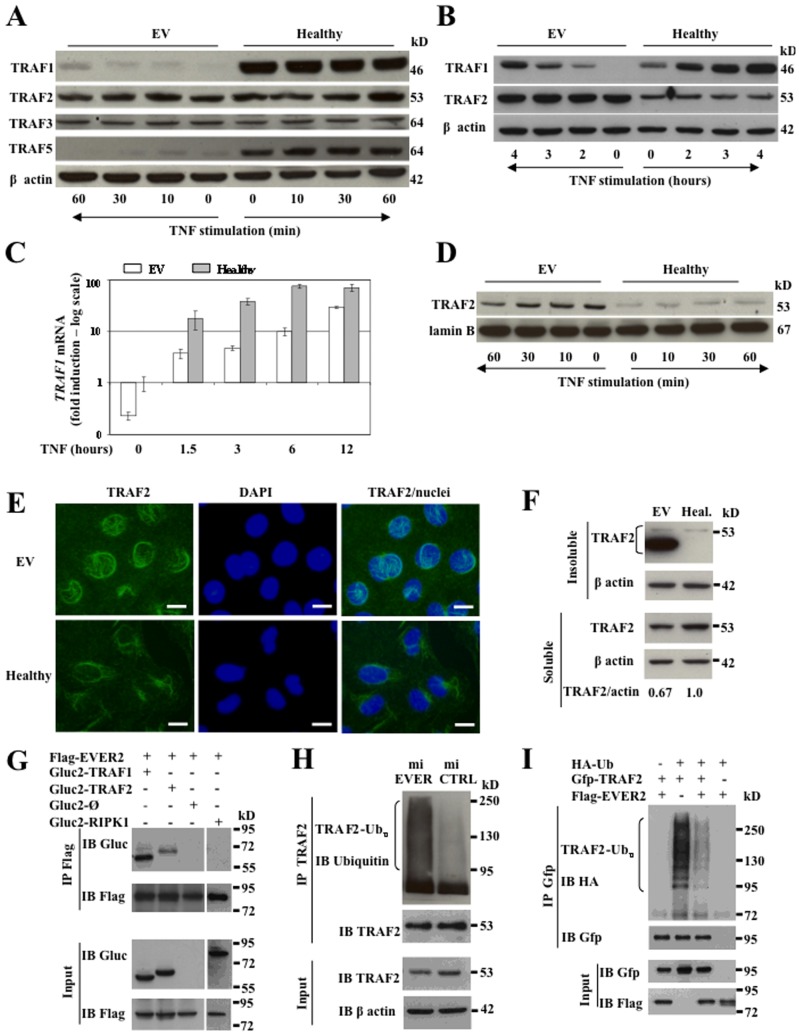
EVER2 deficiency impairs TRAF protein production.(A–D) EV and Healthy cell lines were left untreated or stimulated with TNF for the time periods indicated. (A) Cytoplasmic extracts were subjected to western blotting. The results shown are representative of three independent experiments. (B) Whole-cell lysates were analyzed by western blotting after various times. (C) qRT-PCR was used to measure the induction of TRAF1 1.5–12 h after stimulation with TNF. Results are reported as fold-induction with respect to untreated cells. The basal level for the Healthy cell line was set to 1. A logarithmic (log) scale was used for the Y axis. Experiments were performed twice independently. (D) Nuclear extracts were subjected to immunoblot analysis with TRAF2 antibody for the times indicated. The results shown are representative of three independent experiments. (E–F) EV and Healthy (Heal.) cell lines were left untreated. (E) Cells were stained for TRAF2; the nucleus was stained with DAPI. Bars, 20 µm. (F) Keratinocytes were lysed in Triton X-100 lysis buffer. Soluble and insoluble fractions were subjected to immunoblot analysis with TRAF2 antibody. The TRAF2 and actin bands were quantified by densitometry for the soluble fraction. Results are reported as the ratio of TRAF2 to actin. The ratio obtained for the Healthy cell line was set to 1. (G) HEK-293T cells were transfected with plasmids encoding Flag-tagged EVER2 and Gluc2-tagged TRAF1, TRAF2 or RIPK1 proteins or Gluc2 fragment as a control (Gluc2-Ø). Crude lysates were immunoprecipitated with anti-Flag antibody (IP) and immunoblotted (IB) with the antibodies indicated. (H) Endogenous TRAF2 was immunoprecipitated (IP) with anti-TRAF2 in miEVER2 and control cells, and then subjected to immunoblotting (IB) with anti-Ubiquitin (Ub) antibody. The results shown are representative of three independent experiments. (I) HEK-293T cells were cotransfected with Gfp-tagged TRAF2, hemaglutinin (HA)-tagged Ubiquitin (Ub) with or without Flag-EVER2. After 24 h, the cells were treated with TNF for 2 h. Lysates were subjected to immunoprecipitation and immunoblotting with the indicated antibodies. The results shown are representative of two independent experiments.